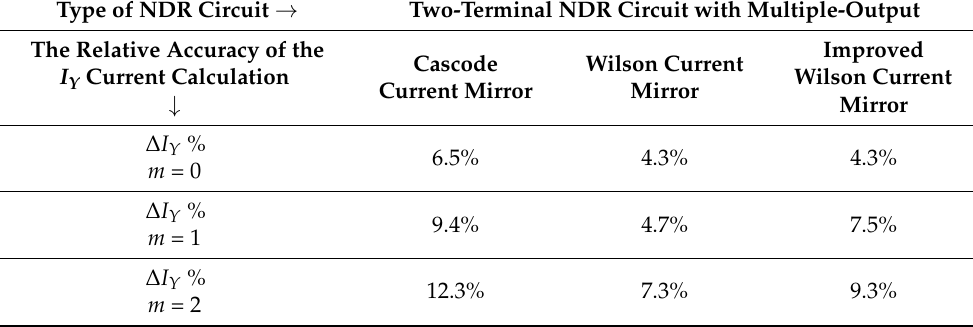
Table 3. The relative accuracy of the I Y current calculation for different two-terminal NDR circuits ( T 0 —JFET).